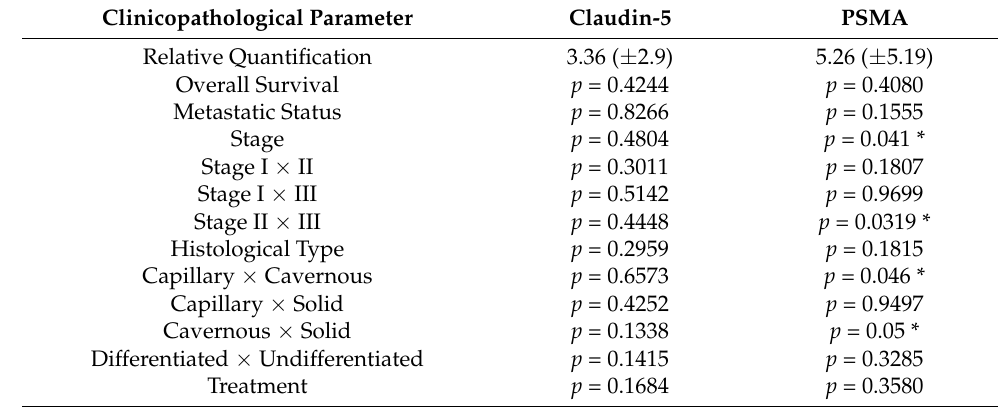
Table 1. Comparison between gene expression of Claudin-5 and PSMA and clinicopathological